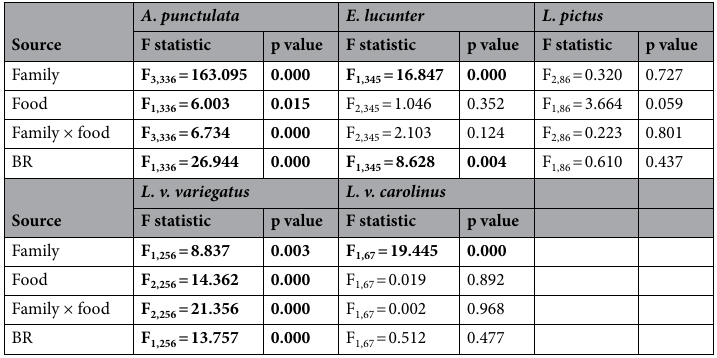
Table 2. Two-factor ANOVAs with body rod (BR) as a covariate for regular urchins. Significant values are in [bold].